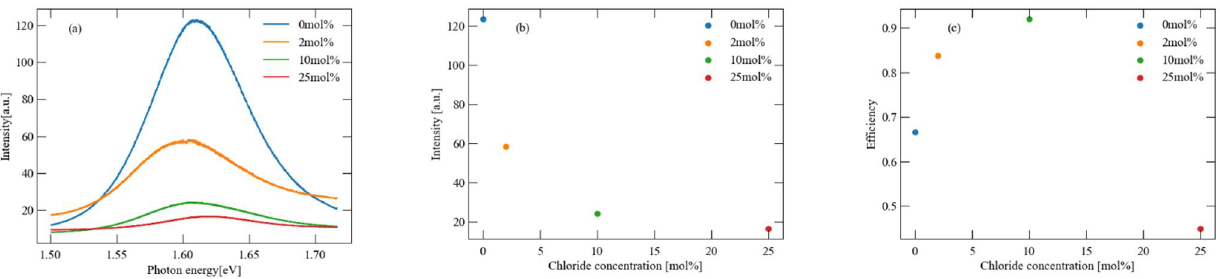
Figure 3. PL ( a ) spectra, ( b ) intensity, and ( c ) intensity ratio (‘efficiency’) of CH 3 NH 3 Pb(Cl,I) 3 with different Cl concentrations on FTO/TiO 2 . Table 1. Summary of device performance of CH 3 NH 3 Pb(Cl,I) 3 solar cells with different Cl concentra- tions obtained from photocurrent density–voltage ( J–V ) curves. The device parameters were